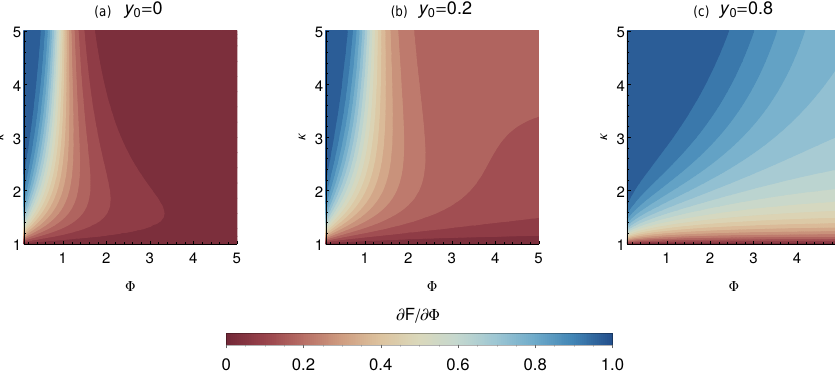
Figure 4. The sensitivity ∂F/∂(cid:56) under varying κ , for y 0 = 0 (left panel), y 0 = 0.2 (center) and y 0 = 0.8 (right panel). Blueish colors denote high and reddish colors low